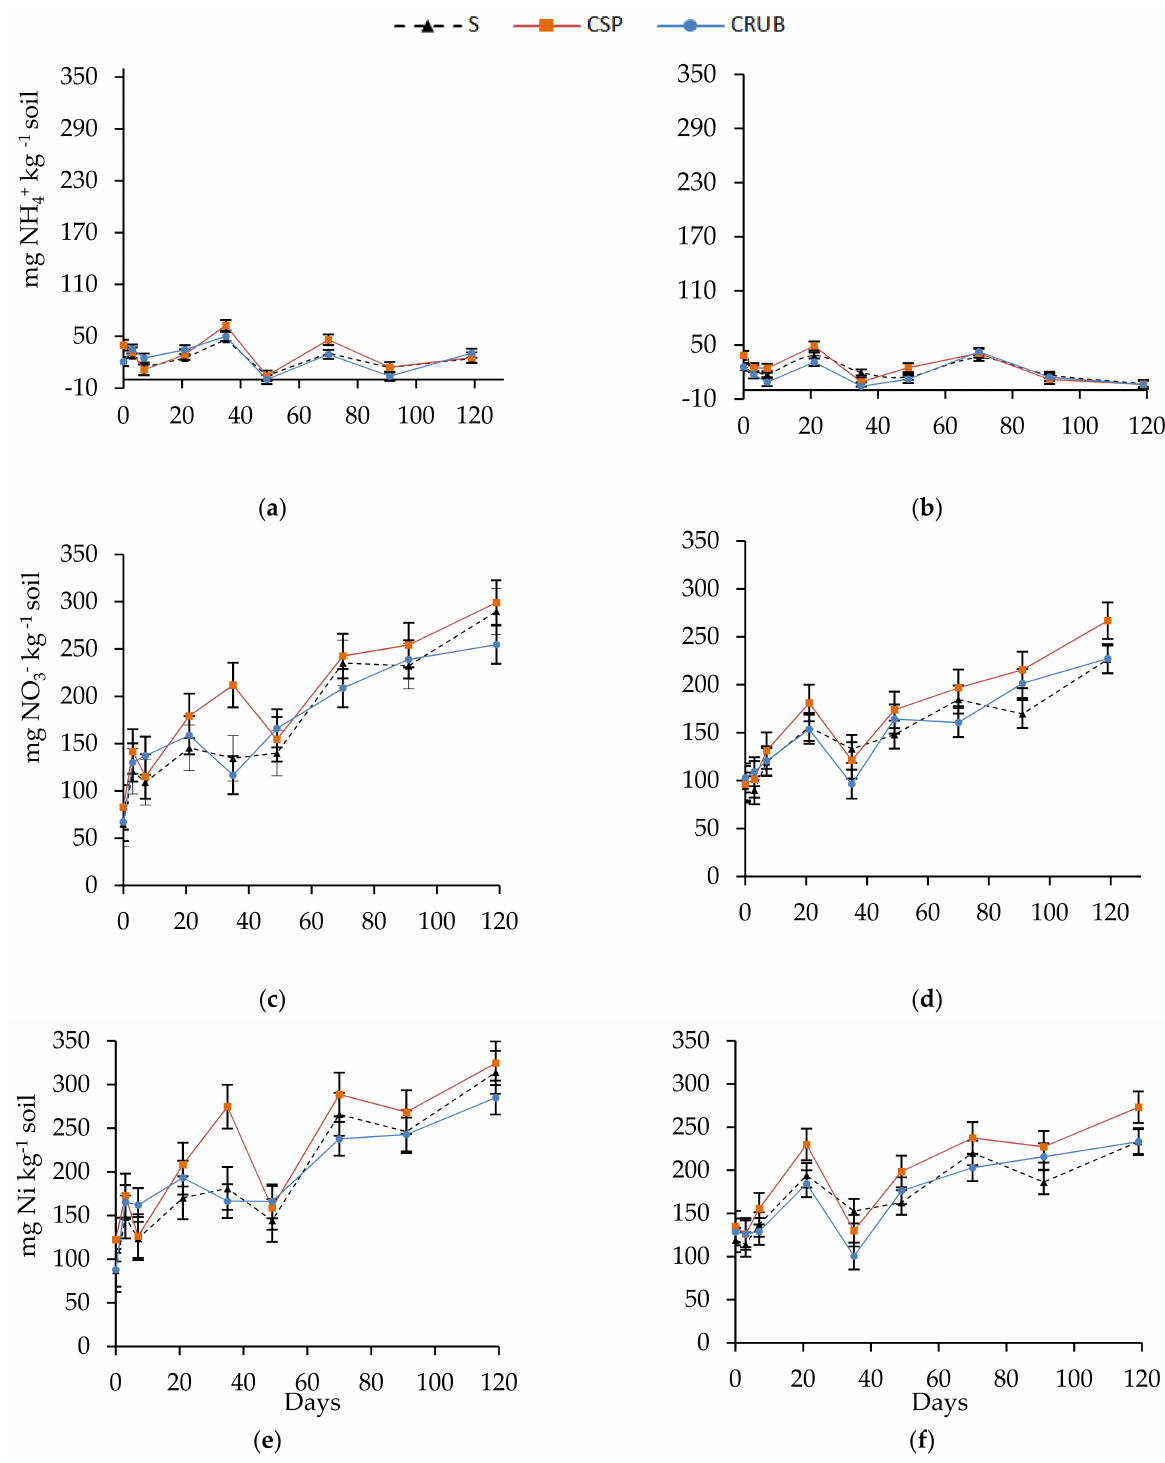
Figure 1. Mineralization of NH 4 + -N, NO 3 − -N, and Ni for each treatment and date. ( a , c , e ): S1; ( b , d ), ( f ): S2. S: control; CSP: poultry manure and wheat straw; CRUB: biosolids and wood shavings. Bars represent standard